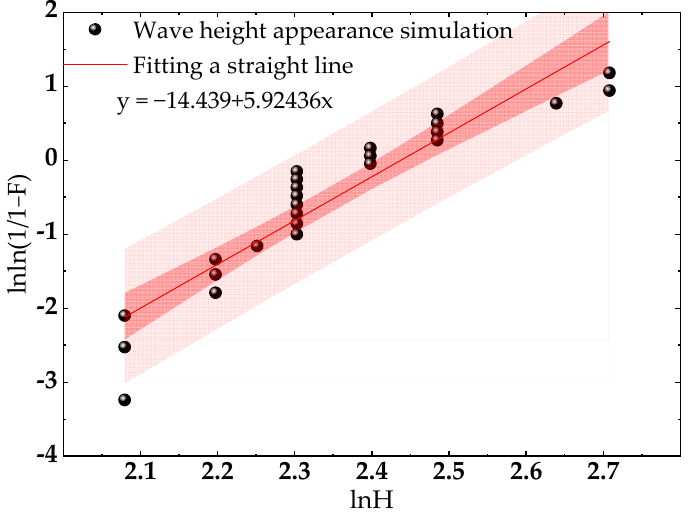
Figure 1. Wave height linear fit.